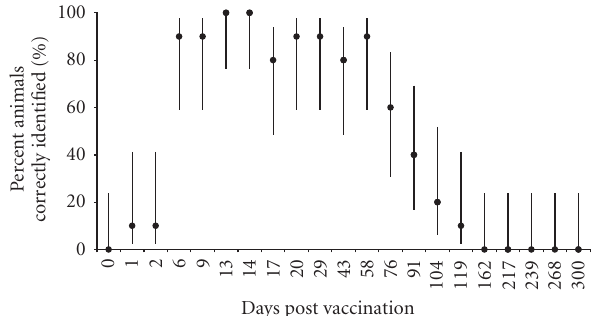
Figure 3: Percent vaccinated animals correctly identified by the RB51-CFT and 95% Credibility Intervals.